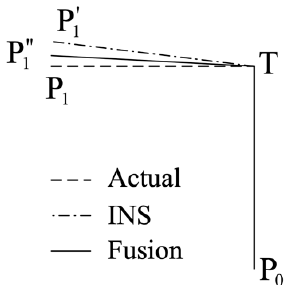
Sensors 2020 , 20 , 4476